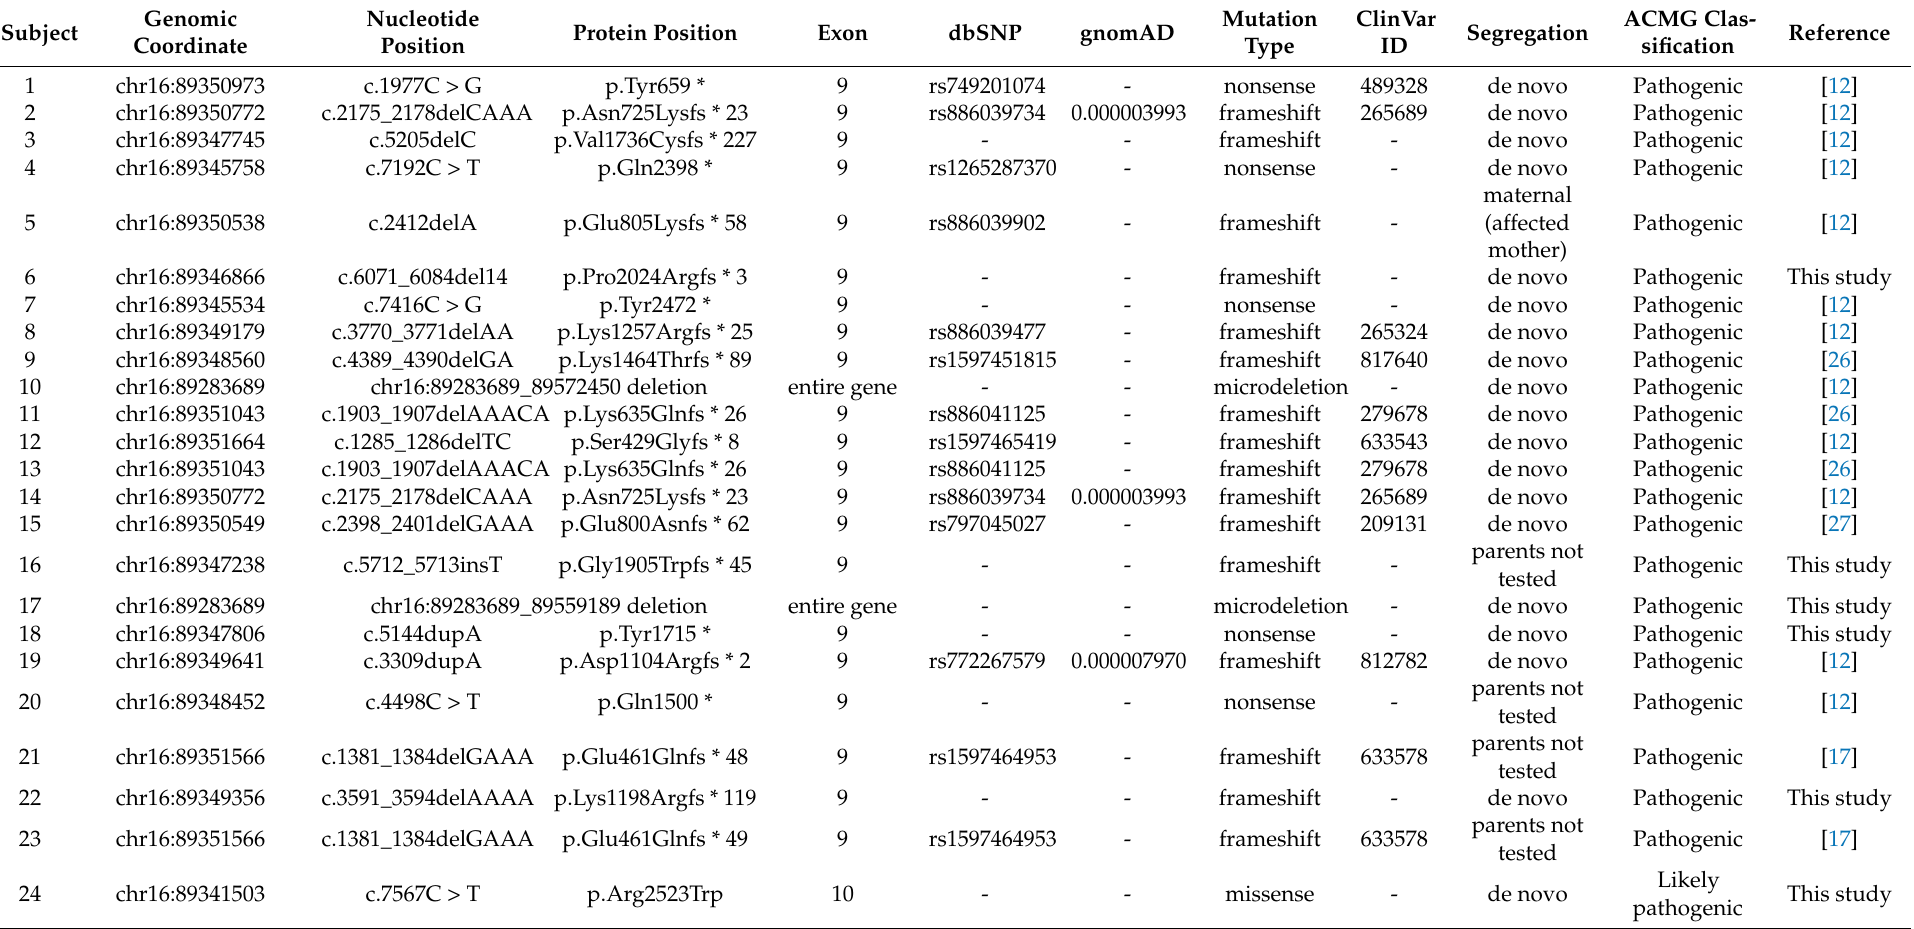
Table 2. List of ANKRD11 variants identified in our cohort/Genotypic summary of our KBG